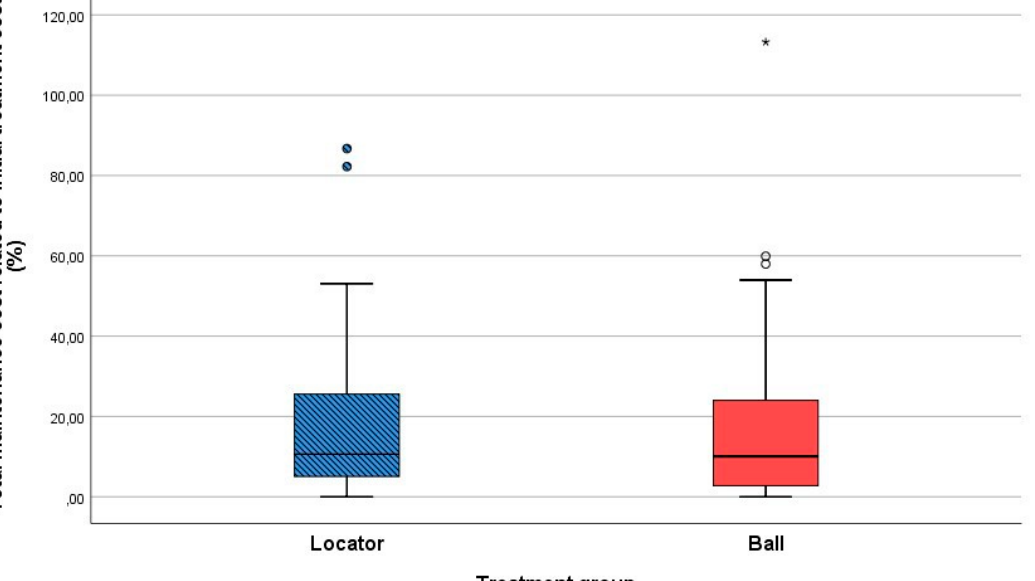
Figure 4. Maintenance costs up to seven years in function in relation to the initial treatment cost for both treatment groups. * and o represent the outliners.